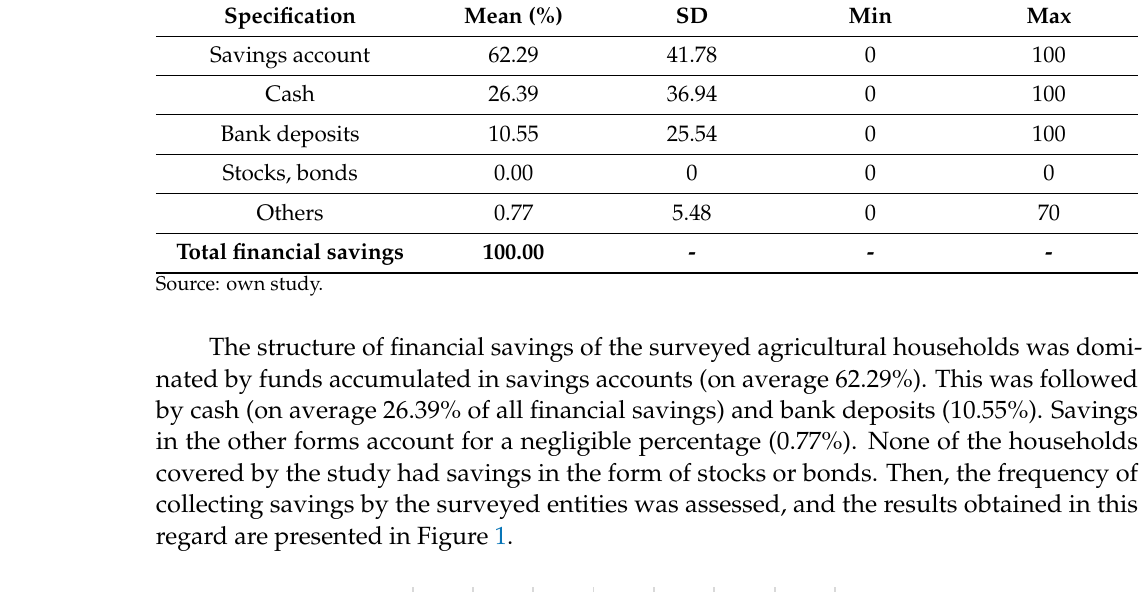
Table 4. The structure of financial savings of the surveyed agricultural households (%, n = 191).